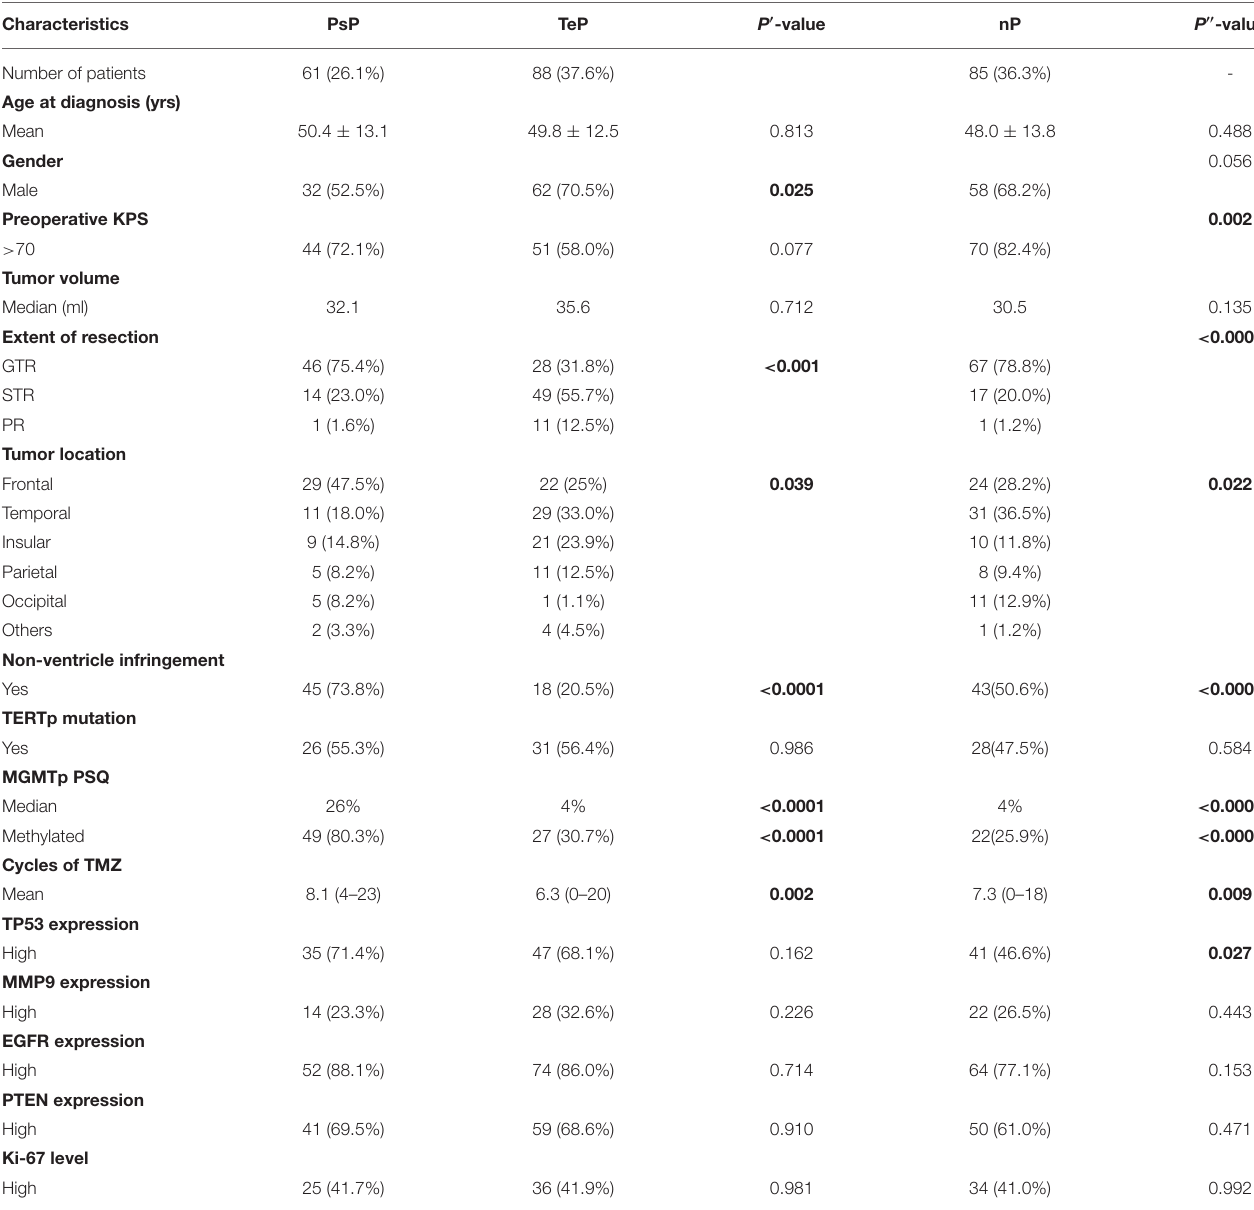
TABLE 1 | Clinical, radiological, and pathological information of pseudoprogression (PsP), true early progression (TeP), neither pattern of progression (nP) patients. Characteristics PsP TeP P ′ -value nP P ′′ -value